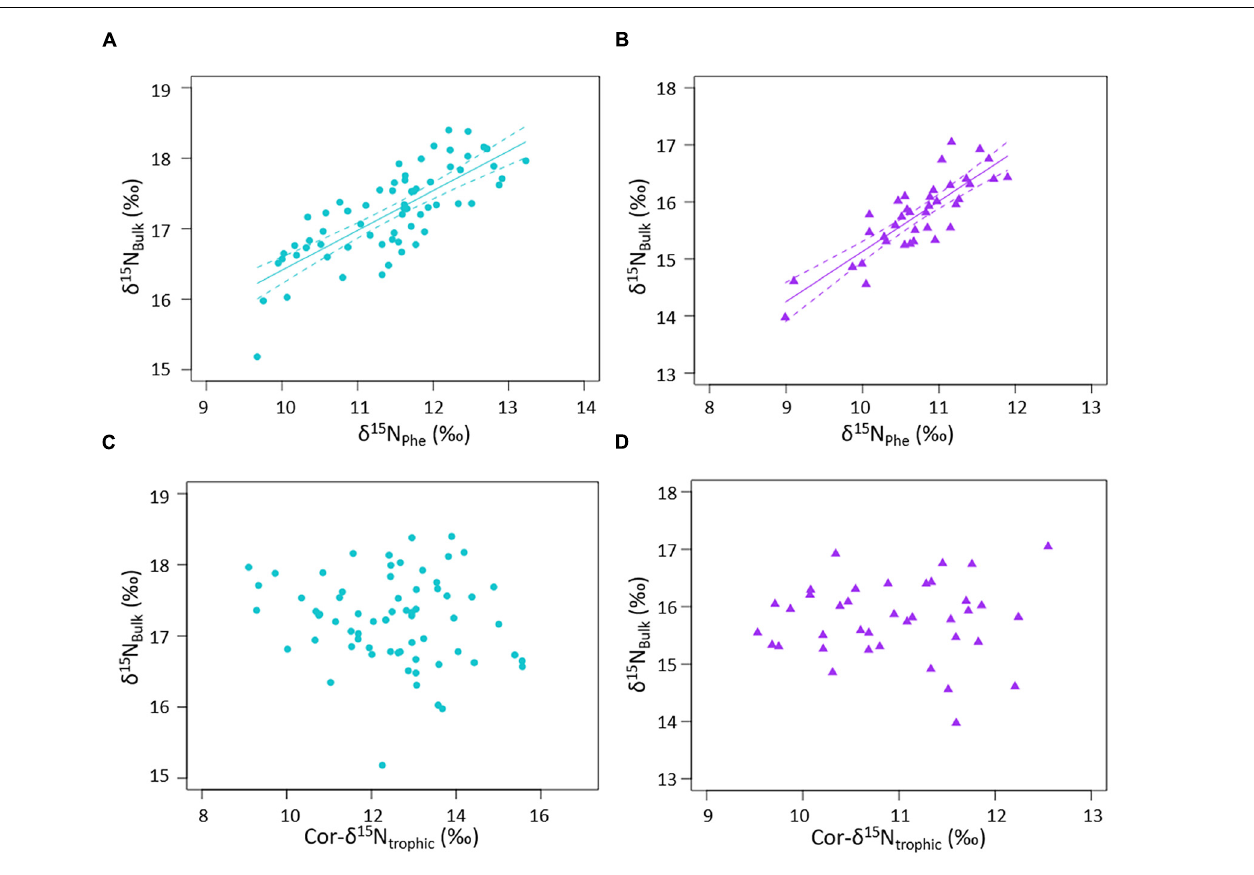
) in ringed seals from (A) the Canadian Arctic Archipelago (CAA; turquoise FIGURE 5 | Relationship between δ 15 N bulk and δ 15 N AA . δ 15 N bulk and δ 15 N Phe in per mil ( circles) and (B) Baffin Island (purple triangles), and relationship between δ 15 N bulk and Cor- δ 15 N trophic in ringed seals from (C) the CAA and (D) Baffin Island; solid lines (cid:104) show significant linear models ( p < 0.01, Table 2 ), dashed lines show 95% confidence intervals of the linear